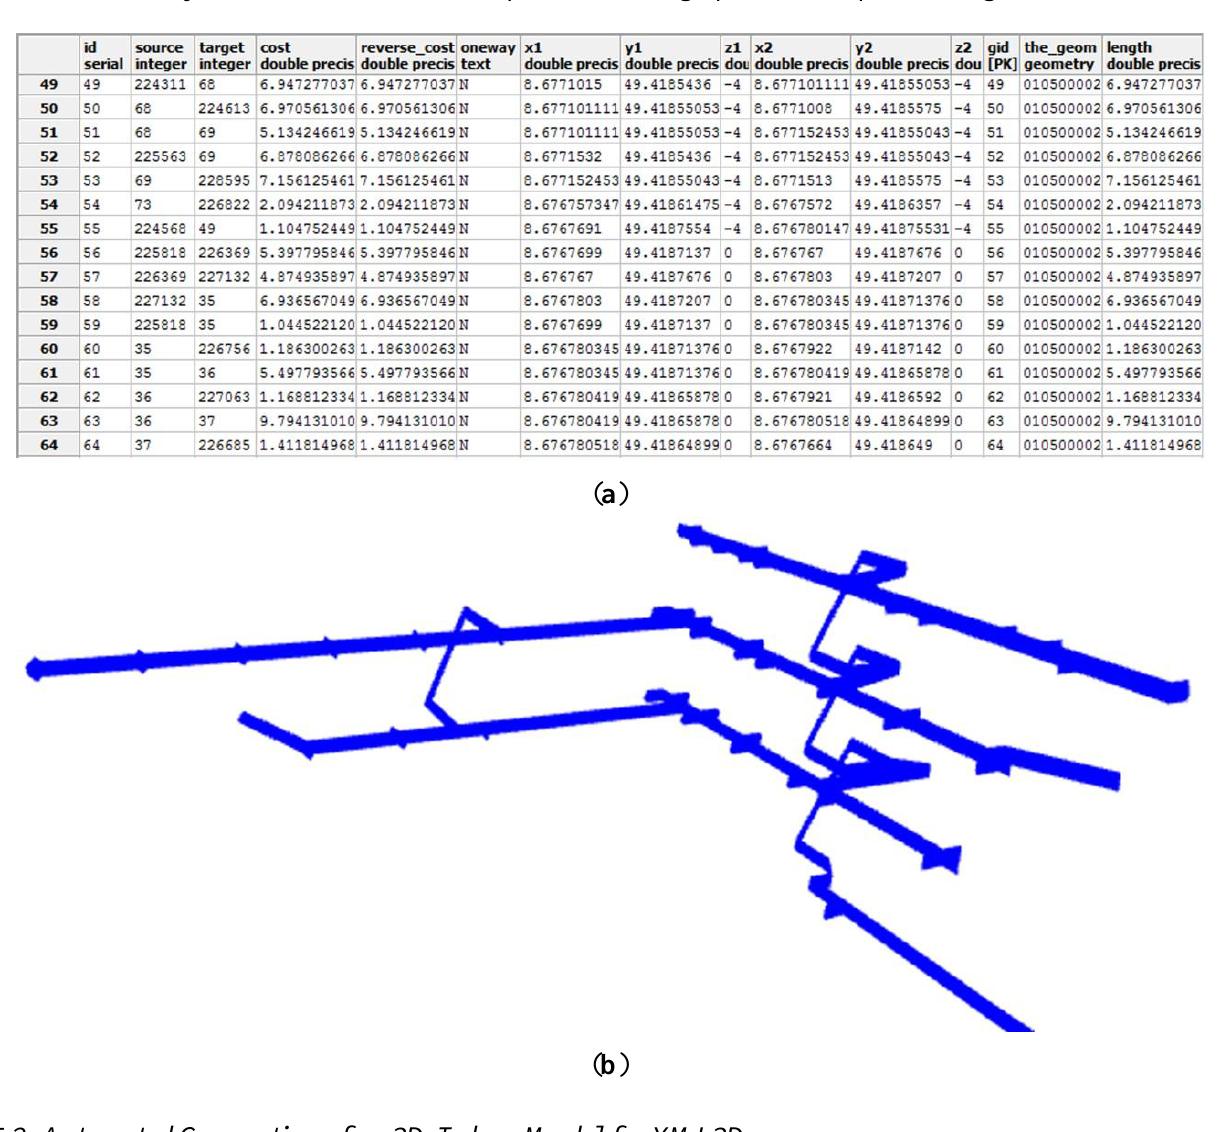
Figure 4. Route graph with x, y, z coordinates of the source and target nodes with connectivity and oneway information ( a ) and a complete 3D route graph for a sample building ( b